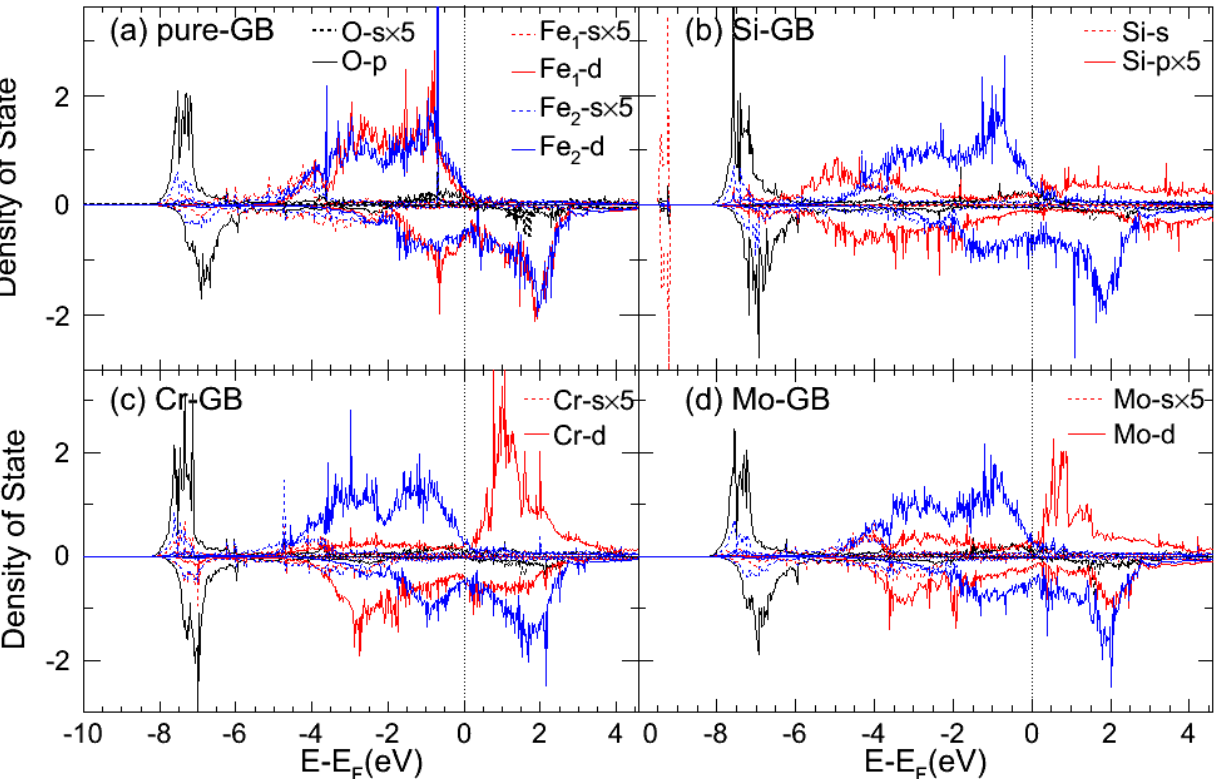
Figure 7. The projected density of states (pDOS) of O with Fe, Si, Cr and Mo atoms. Fe1 and Fe2 represent Fe atoms in the first layer and second layer of the ( a ) pure Fe-GB, ( b ) Si-alloyed GB, ( c ) Cr-alloyed GB, ( d ) Mo-alloyed GB, respectively.